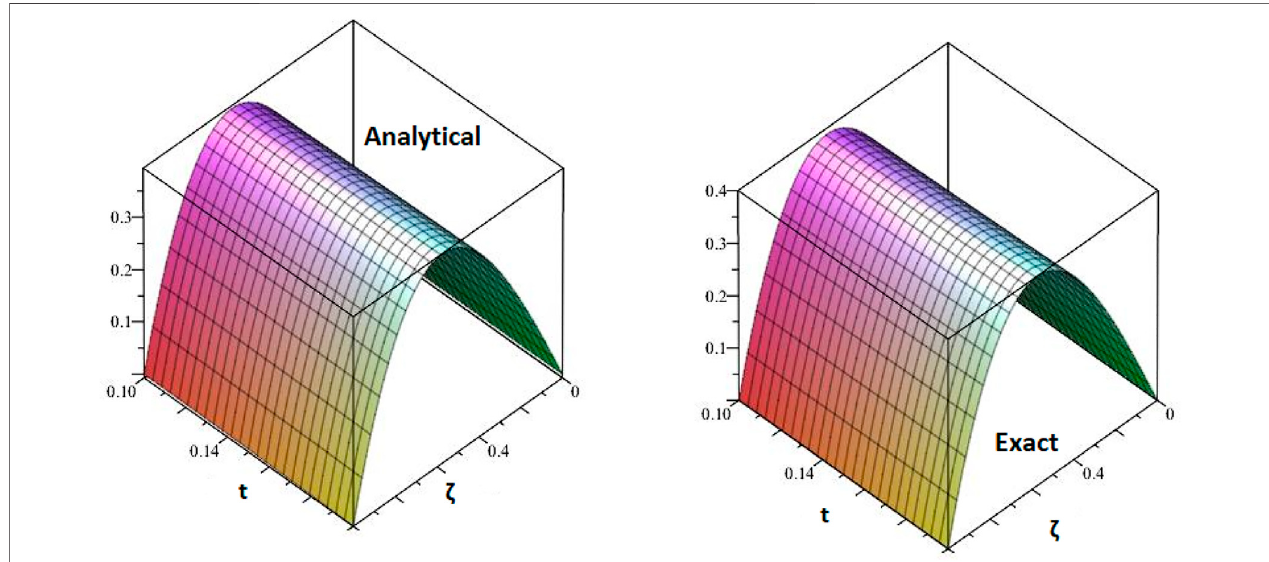
FIGURE 5 | 3D plots for the exact and analytical solution at γ =1 for Example